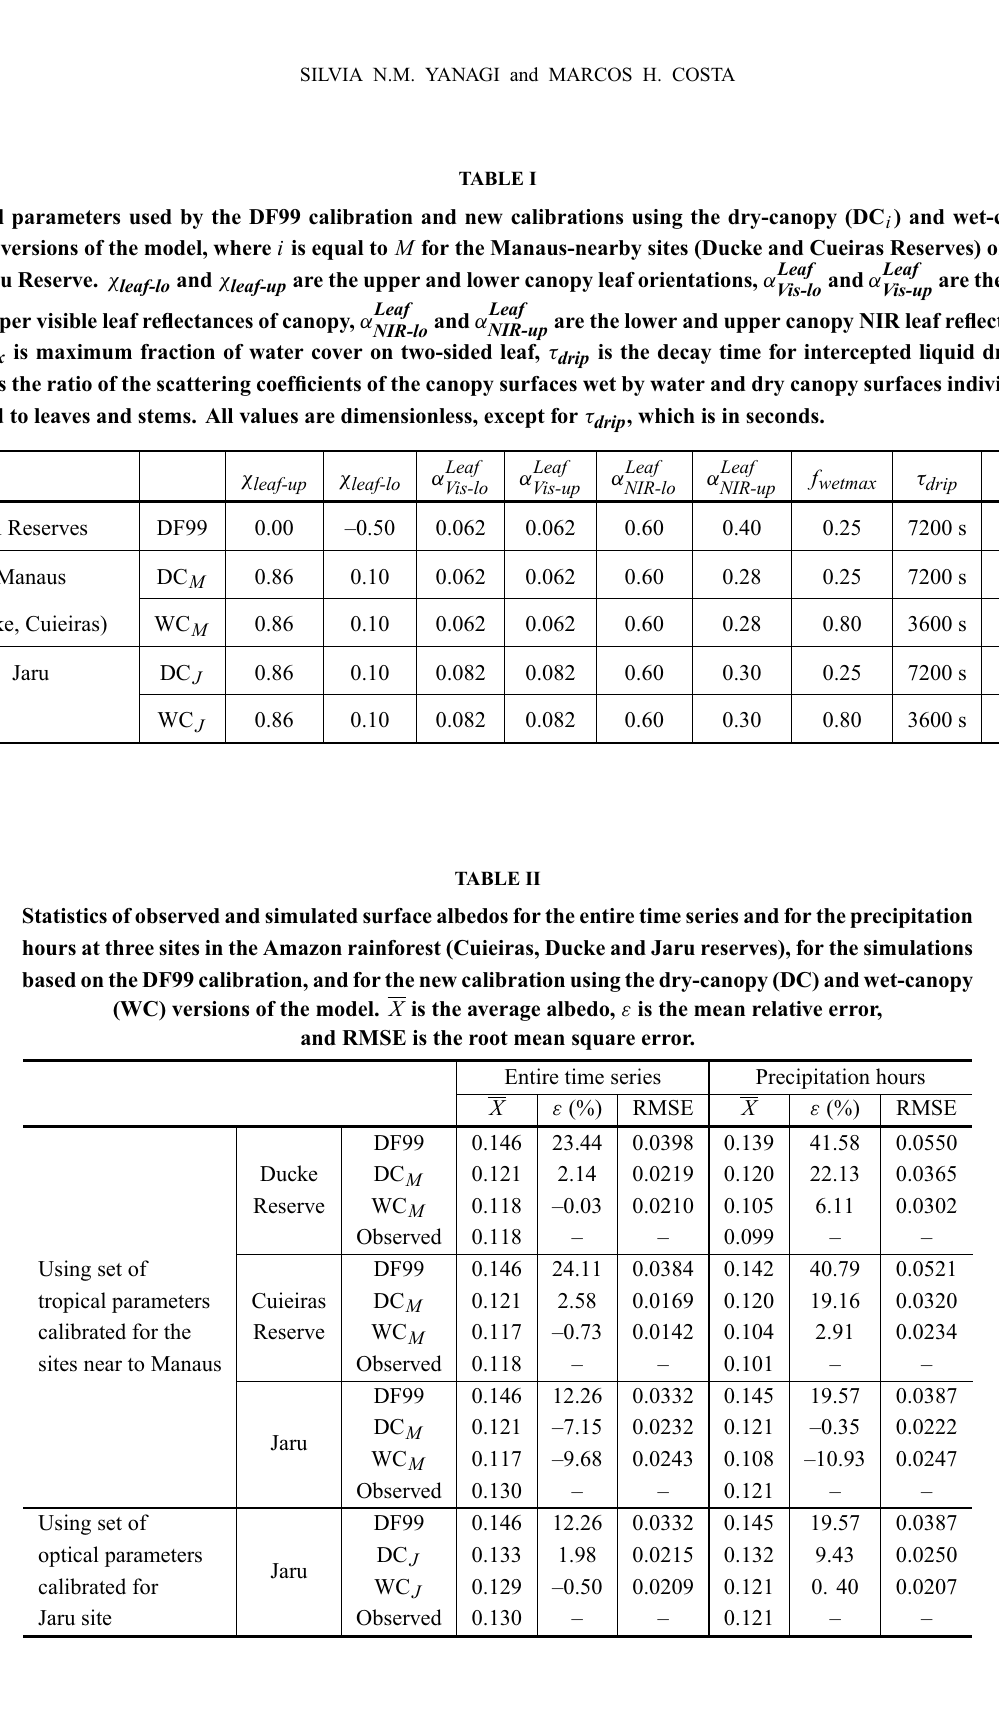
Leaf Leaf and α are the lower Vis-up Vis-lo Leaf Leaf and α NIR-up are the lower and upper canopy NIR leaf reflectances, NIR-lo